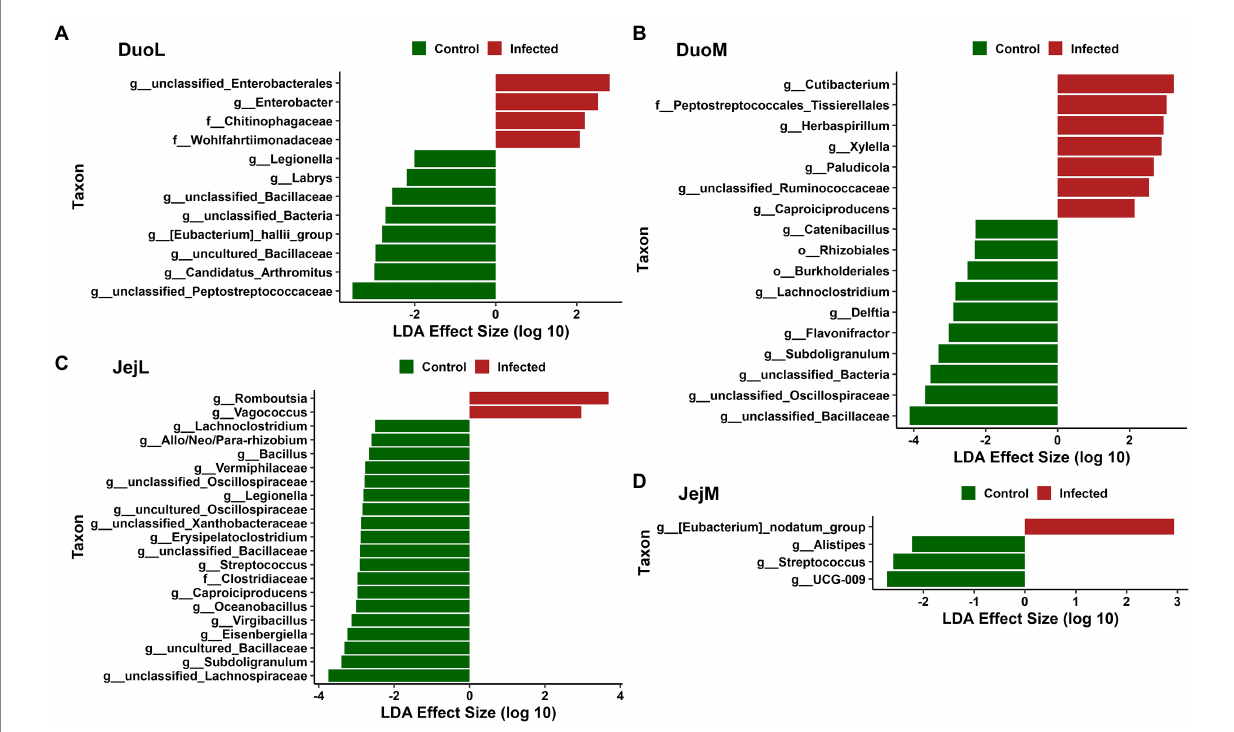
FIGURE 5 Linear discriminant analysis effect size (LEfSe) in: (A) duodenal luminal (DuoL) microbiota, (B) duodenal mucosal (DuoM) microbiota, (C) jejunal luminal (JejL) microbiota, and (D) jejunal mucosal (JejM) microbiota. Positive effect size indicates higher relative abundance in Eimeria acervulina -infected birds, while negative effect size indicates higher relative abundance in control